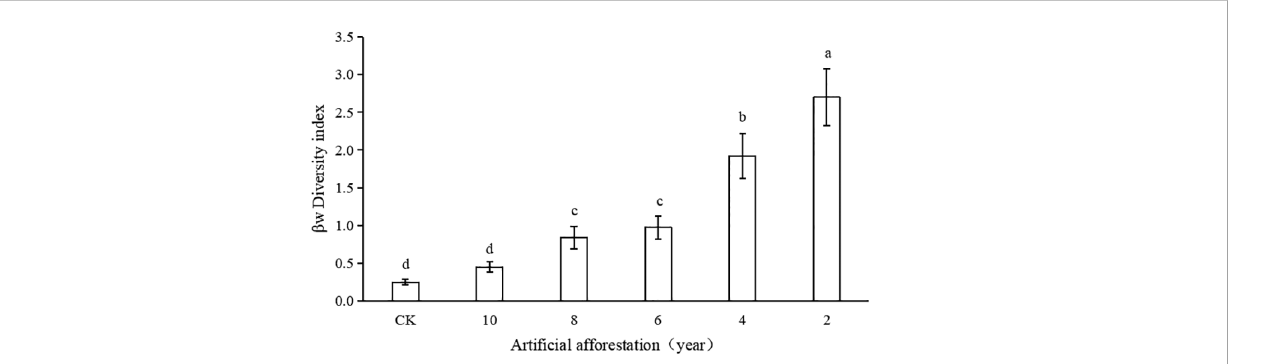
FIGURE 4 b -Diversity index of grassland plant communities with different years of arti fi cial afforestation in the Maxian Mountains of the Loess Plateau. Different lowercase letters indicate statistically signi fi cant differences in b -diversity index of grassland plant communities between arti fi cial afforestation years by LSD test (p< 0.05).